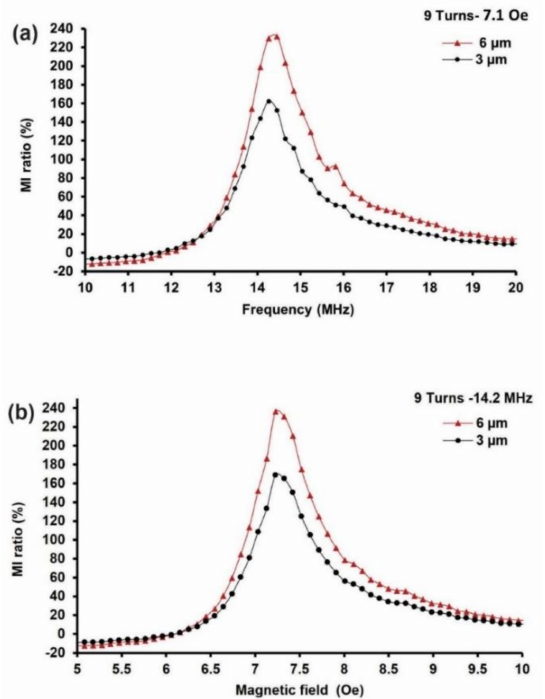
Figure 4. Results of the 9-turn MI biosensor based on different film thicknesses. ( a ) Frequency dependence of the MI ratio at 7.1 Oe. ( b ) Field dependence of the MI ratio obtained at 14.2